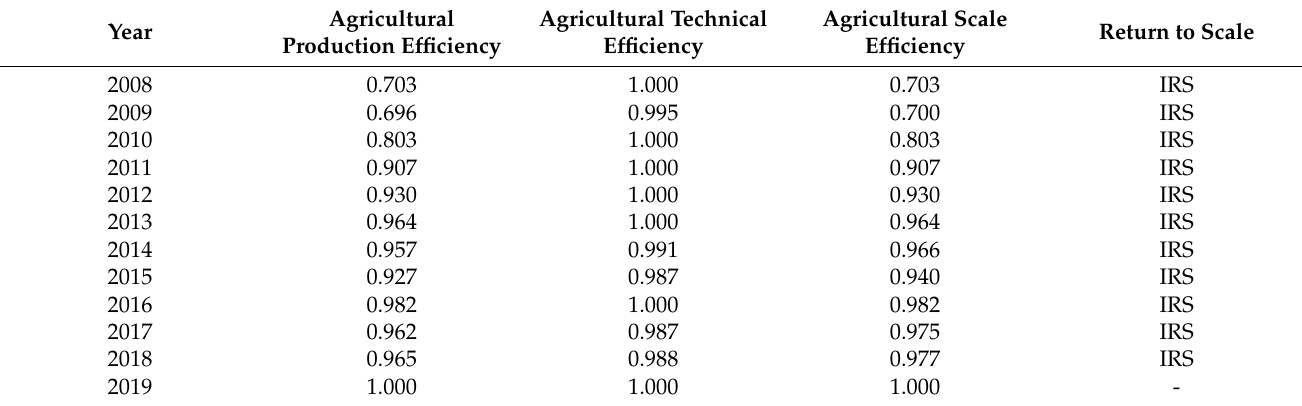
Table 3. Measurement of agricultural production